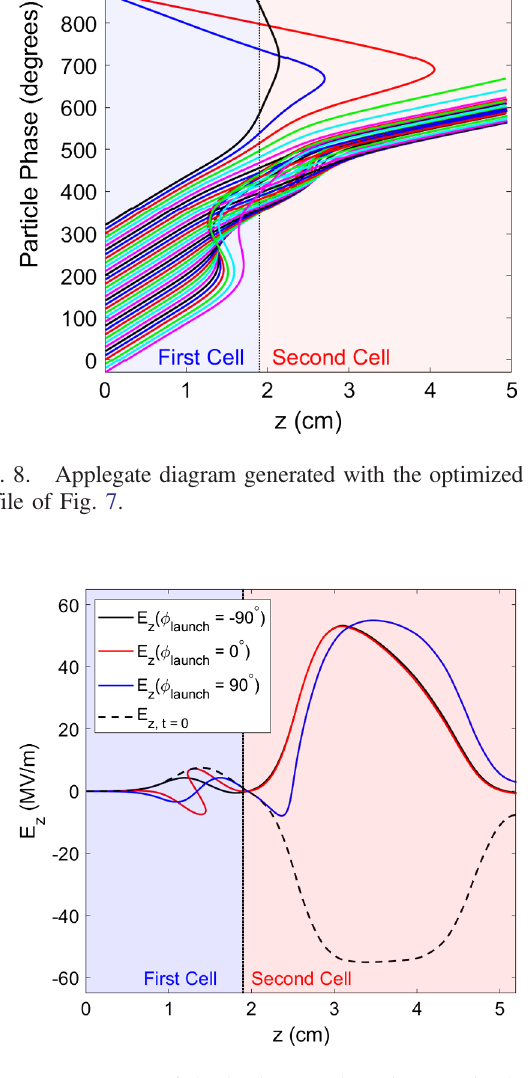
FIG. 9. Recapture of the back-streaming electrons in the first cell. The dashed black line is the optimized field profile. The solid lines are the fields seen by the electrons launched at phases indicated in the